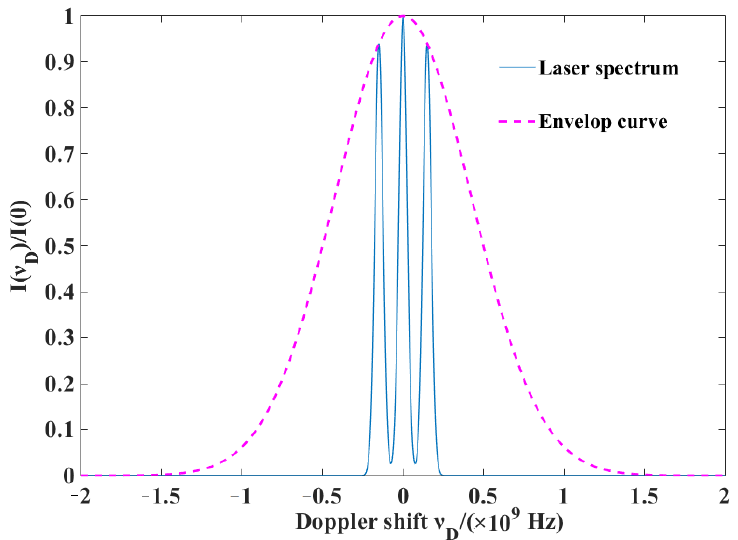
Figure 13. A laser spectrum with three modes at δ v 0 = 6 × 10 7 Hz. (The maximum value is normalized.) Figure 15 depicts the average spontaneous emission rates for the laser intensity from 0 to 200 W/m 2 at δ v 0 = 10 4 Hz and 60 MHz for the three-mode laser and at δ L the mono-mode